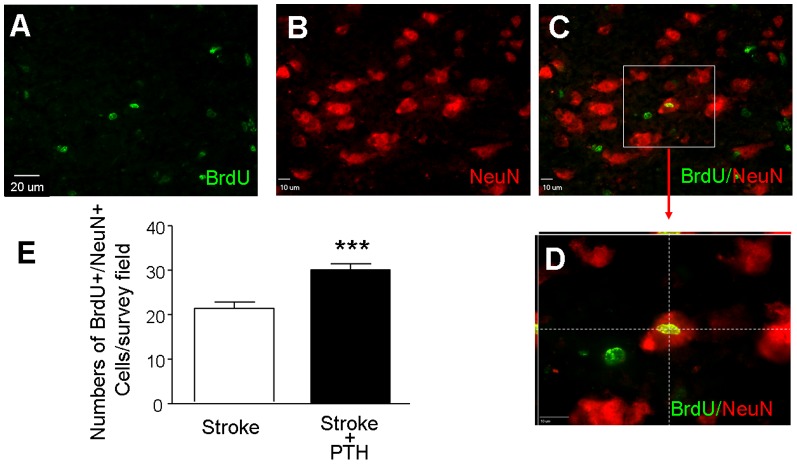
PTH enhanced neurogenesis at the peri-infarct region 21 days after stoke.Neurogenesis in the peri-infarct region was examined by the colocalization of the neuronal marker NeuN (red) and the proliferation marker BrdU (green) 21 days after stroke. A to C. Immunostaining images of NeuN+ cells (A), BrdU+ cells (B) and the merged image of NeuN+ and BrdU+ cells (C). D. Enlarged images of colocalization of NeuN/BrdU from the frame shown in C. E. Cell counts were performed in six randomly chosen fields per section in the peri-infarct region. The total number of cells in six sections was summarized for each mouse. Cell counts show increased numbers of Neu+/BrdU+ cells in the PTH treatment group compared with the stroke/saline group. N = 6 animals each group, *** P<0.001 vs. stroke controls.